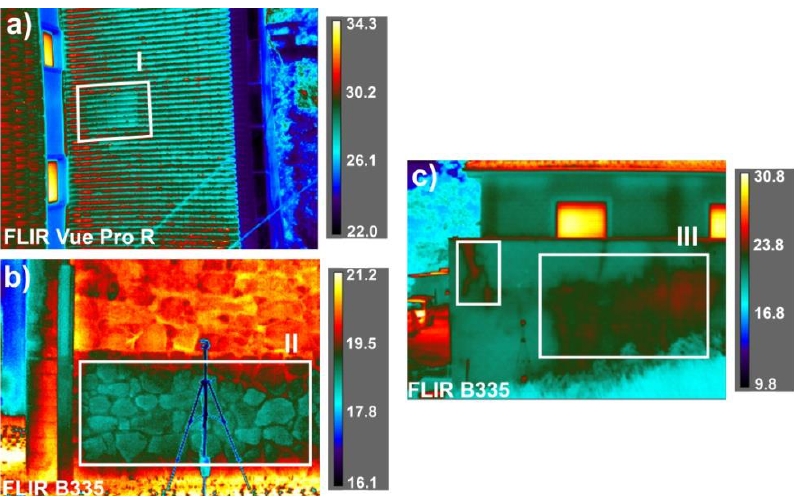
Figure 4. Sample thermal inspection images of the building from the exterior: ( a ) Aerial image of the roof from the drone with the FLIR Vue Pro R and ( b ) and ( c ) two images for wall inspection taken with the FLIR B335. Some detected thermal anomalies are highlighted: (I) a recently replaced group of roof tiles, (II) different coverings of the Southwest façade, and (III) water filtration through wall cracks in the Southeast façade. The temperature scale is in °C.